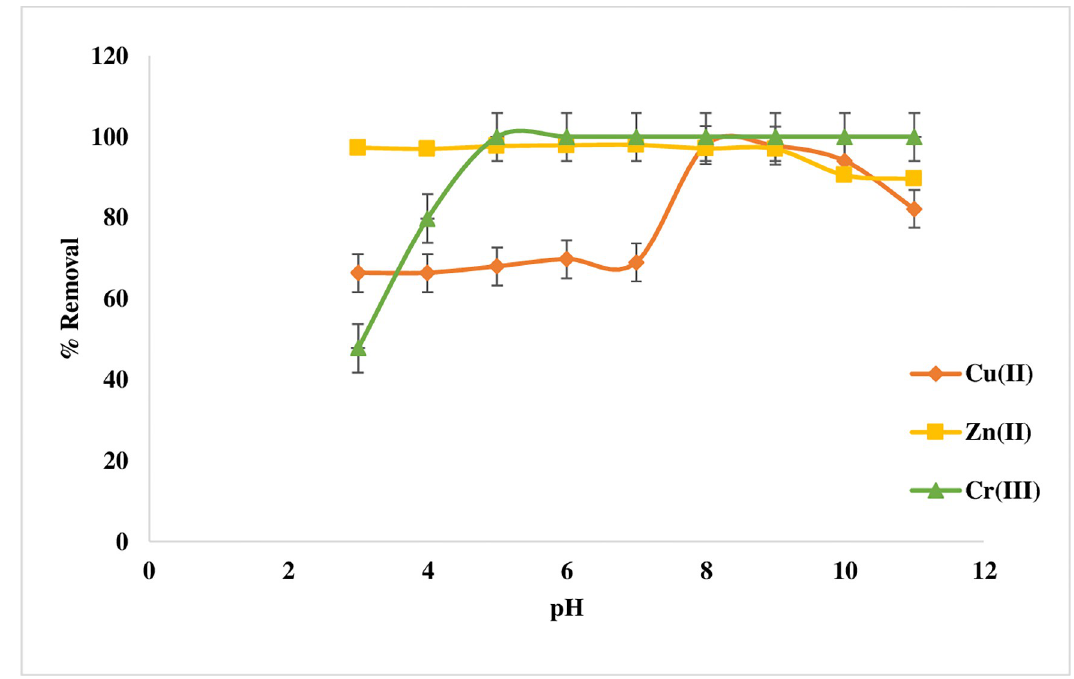
Fig 7. Curve of pH Effect for Cu(II), Zn(II), and Cr(III) adsorption on